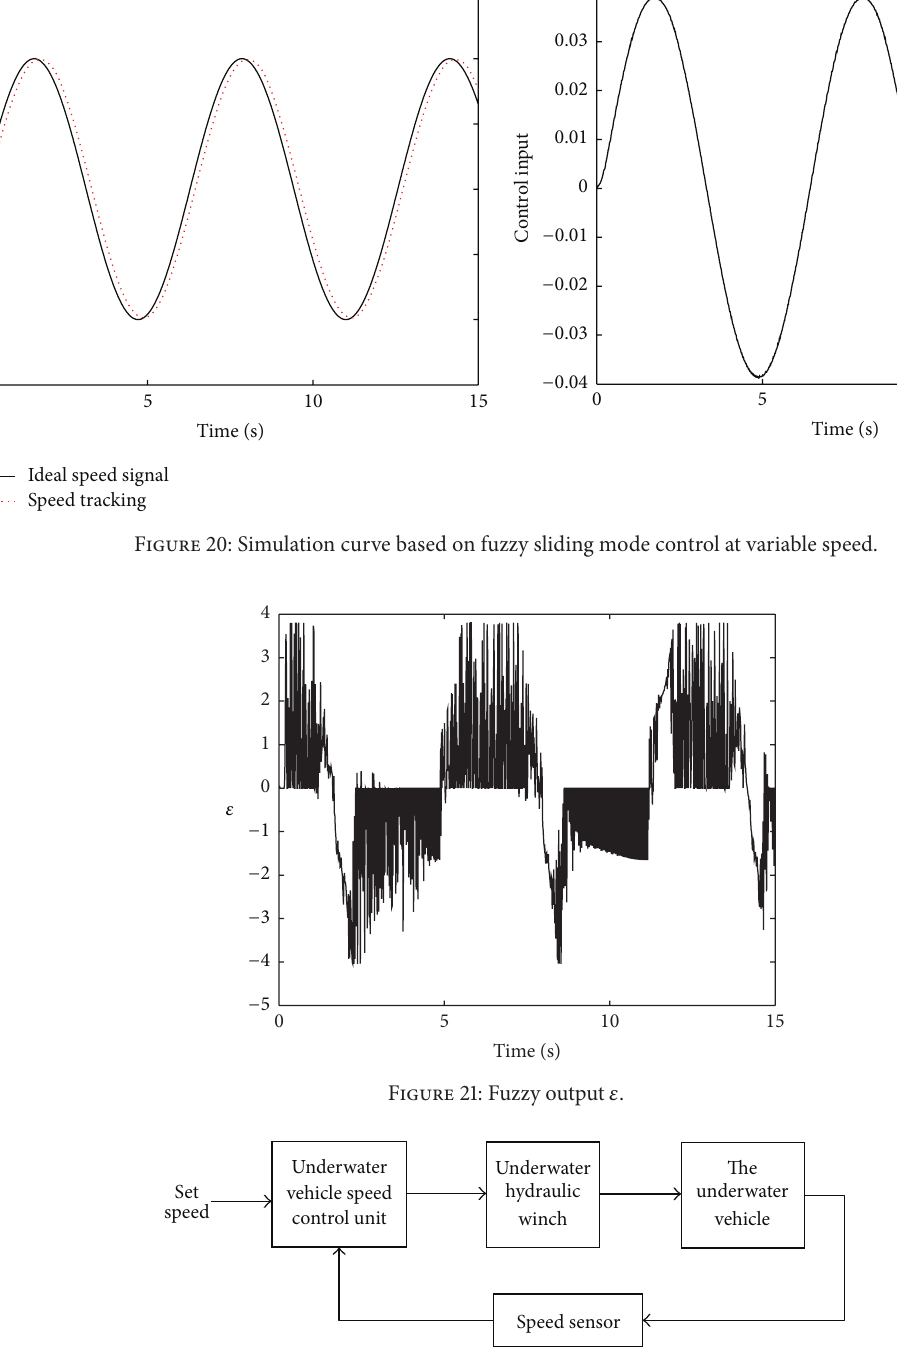
Figure 22: The schematic diagram of practical